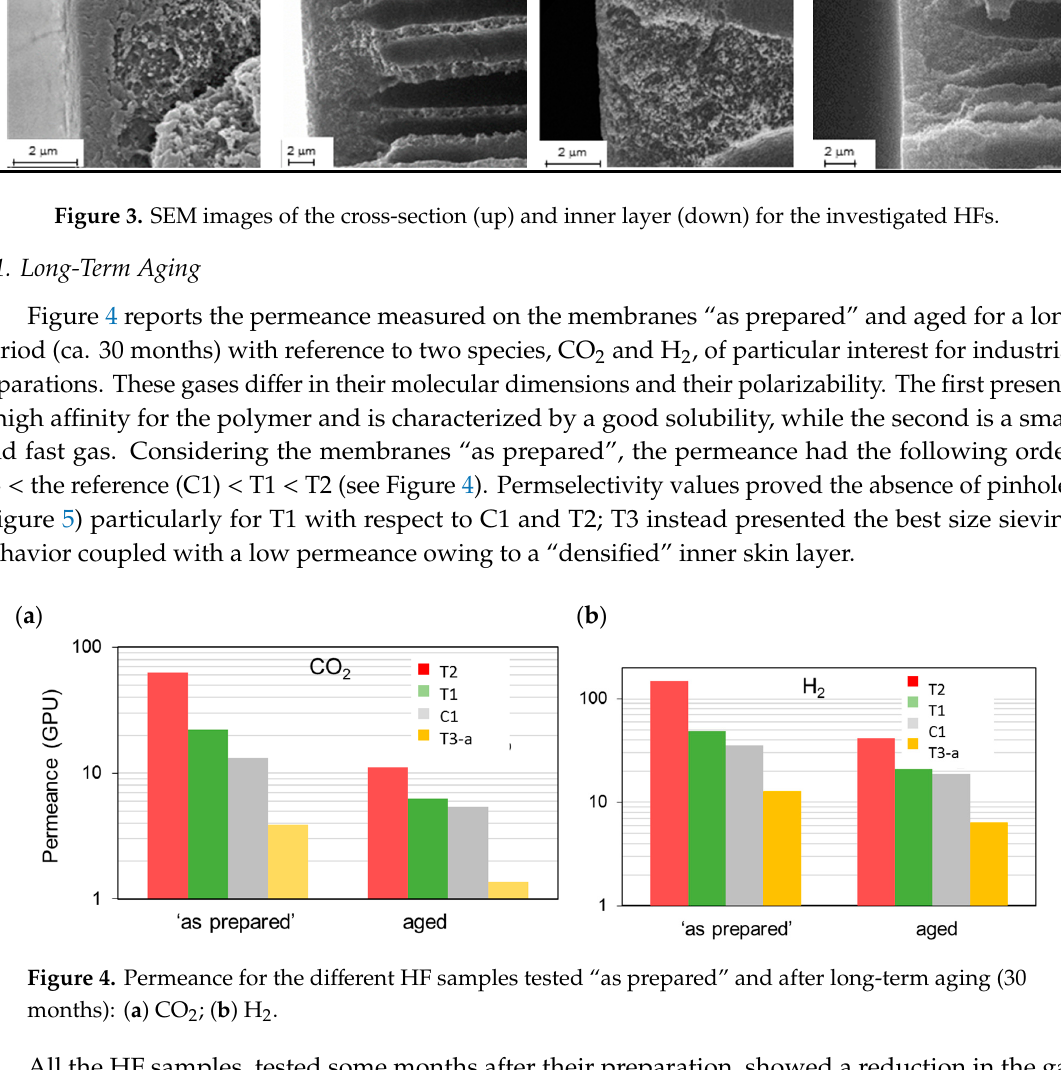
Figure 3. SEM images of the cross-section (up) and inner layer (down) for the investigated HFs.